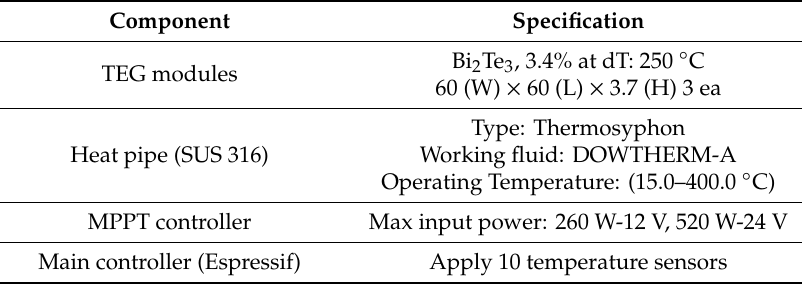
Figure 3. Schematic diagrams of the thermoelectric generator (TEG) system and heat pipe ( a ) TEG system; ( b ) heat pipe. Table 2. Specifications of the TEG system.